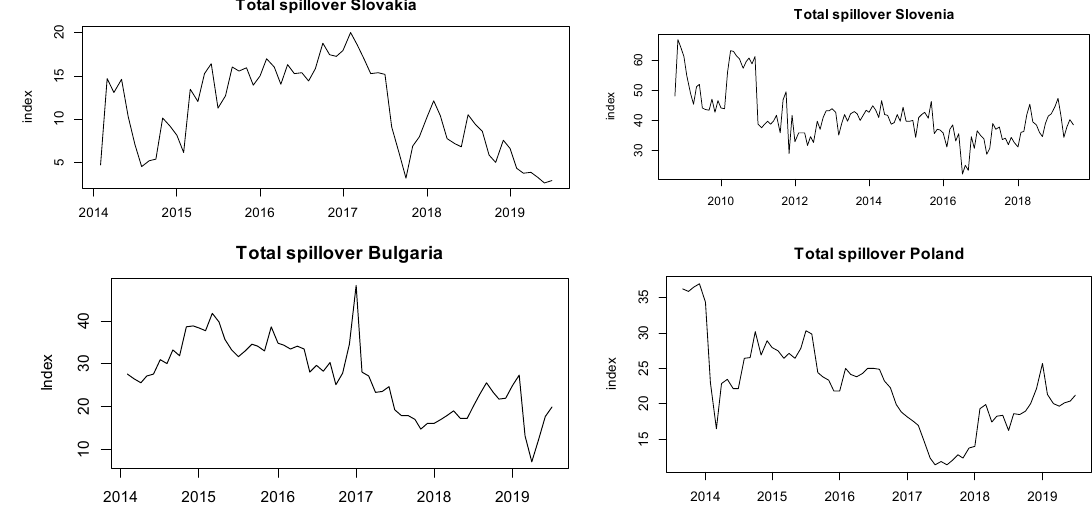
Figure 2. Total spillover indices (from top to bottom, left to right): Slovakia, Slovenia, Bulgaria and Poland.